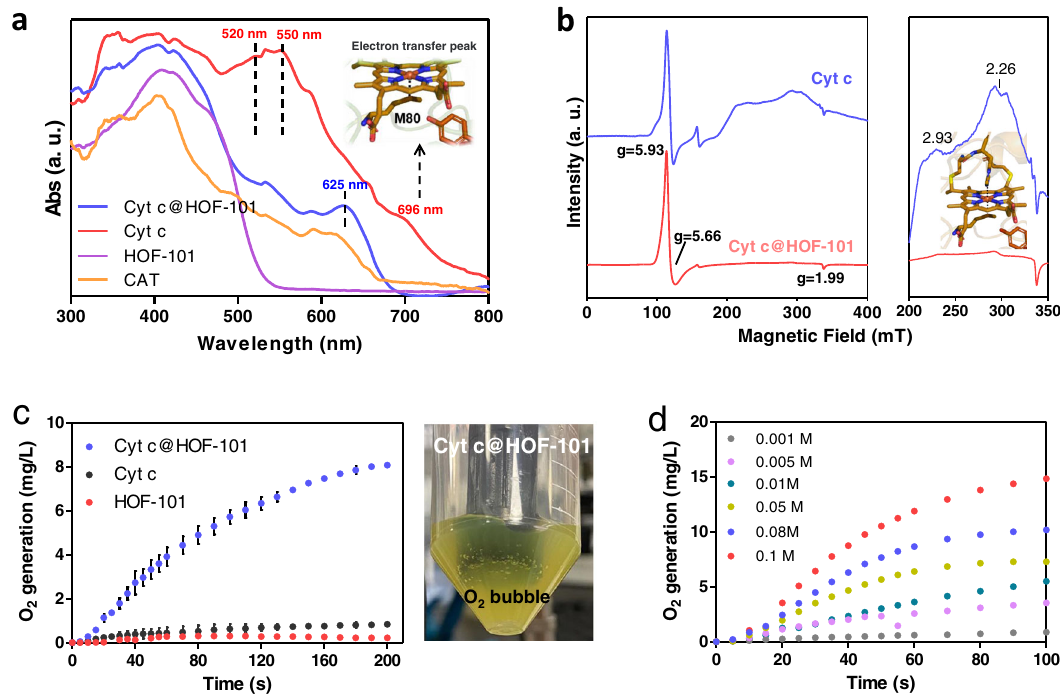
Fig. 3 | The conformation change and CAT-like biofunctionality. a Normalized UV-Vis DRS of Cyt c@HOF-101, Cyt c, HOF-101 and CAT. b The 0 – 400 mT and the zoomed 200 – 350 mT regions of the EPR spectra of free Cyt c and Cyt